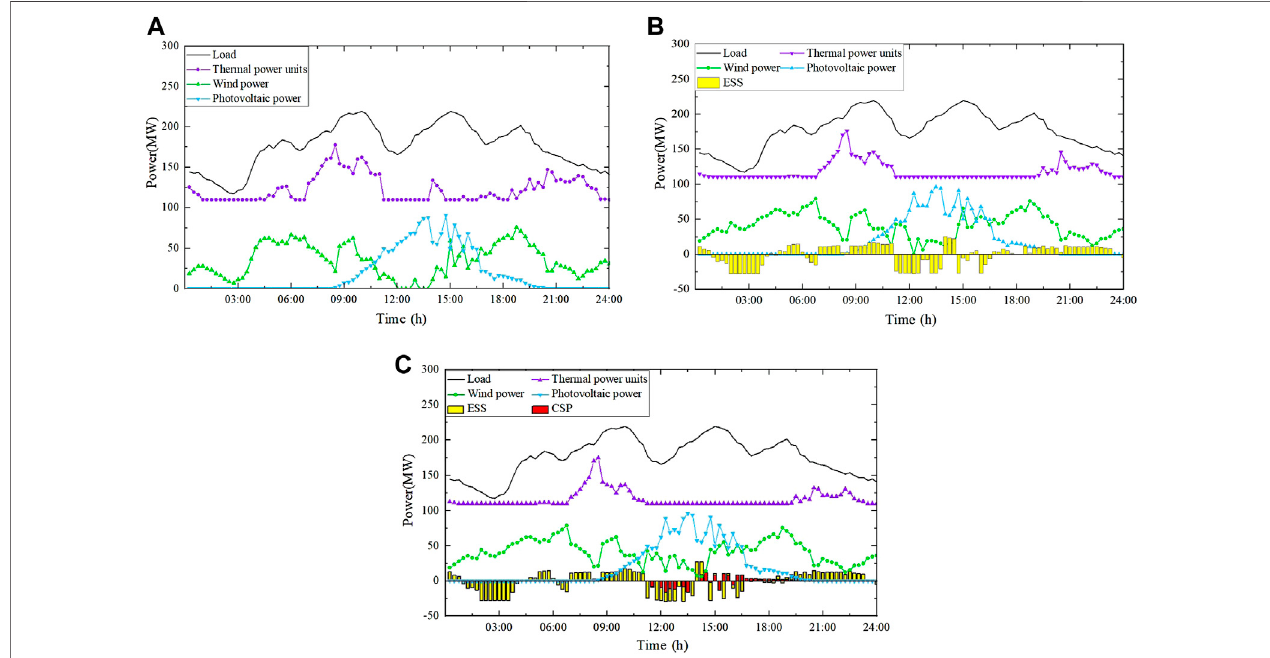
FIGURE 5 | The power balance of regional renewable energy grid with models 1,2 and 3 (A) the day-ahead scheduling results of model 1; (B) the day-ahead scheduling results of model 2; (C) the day-ahead scheduling results of model 3.